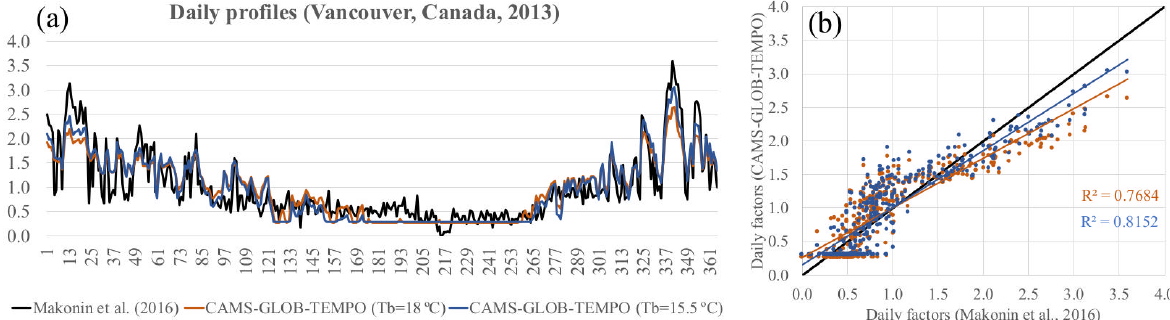
Figure 10. (a) Comparison between daily temporal factors obtained in a location in Vancouver (Canada) for 2013 from real-world mea- surements of residential natural gas consumption (Makonin et al., 2016) and from the residential and commercial gridded temporal profiles reported by CAMS-GLOB-TEMPO. Two versions of the CAMS-GLOB-TEMPO temporal factors are shown as a function of the base tem- perature ( T b ) assumed when applying the heating-degree-day approach (18 ◦ C in orange and 15.5 ◦ C in blue). (b) Scatterplot showing the trend lines and R 2 values obtained from the comparison between measurement-based and CAMS-GLOB-TEMPO daily factors.